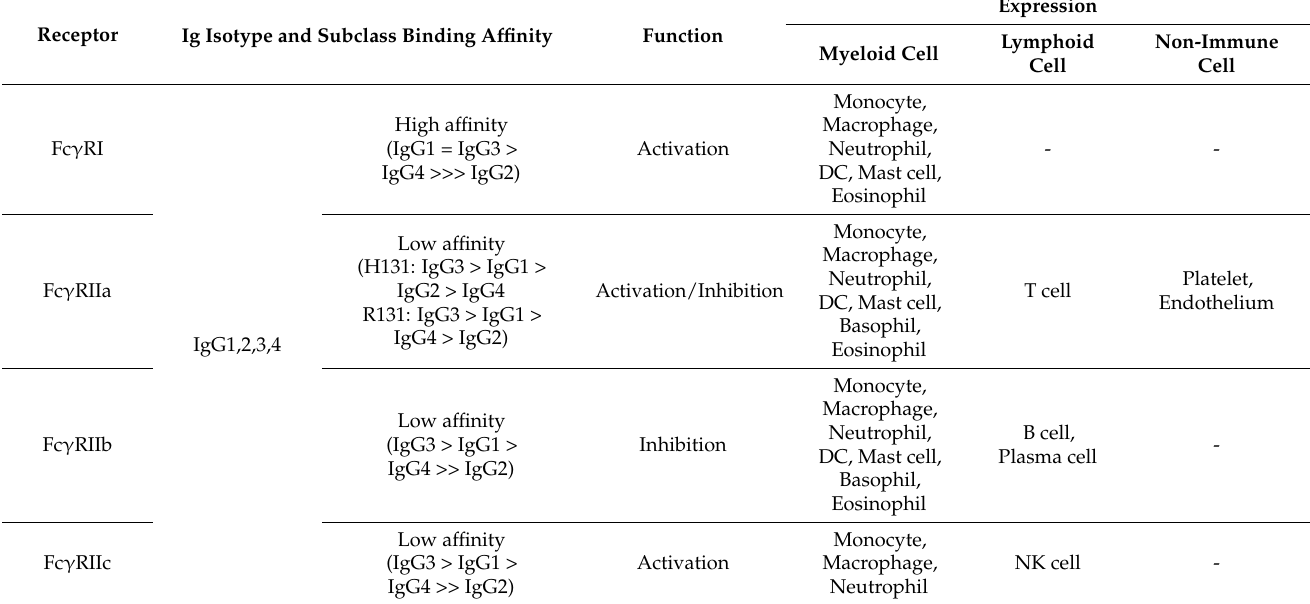
Table 1. Ig binding affinity, function, and expression of individual